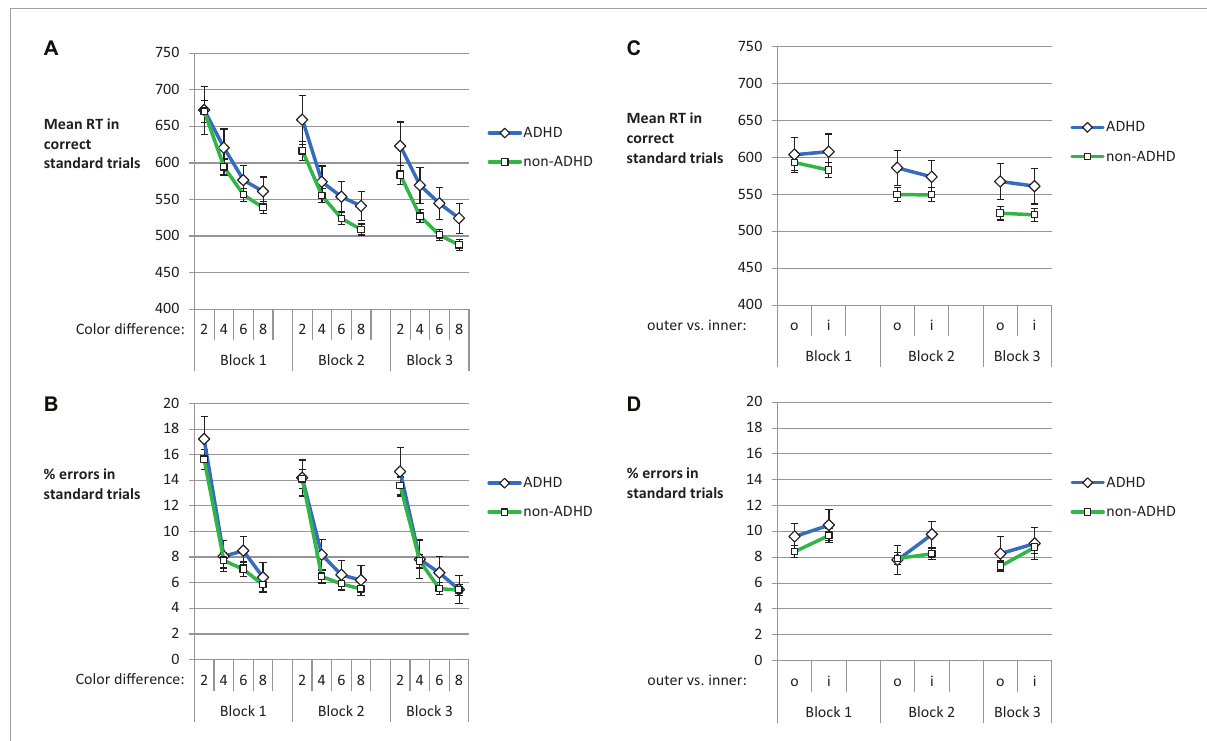
FIGURE3 Mean RT (A) and error rate (B) in standard trials depending on color difference for Blocks 1, 2, and 3. Panels (C,D) show the mean RT and error rate for outer and inner stimulus positions (o and i for outer and inner position). The error bars depict the between subjects SE of the mean.